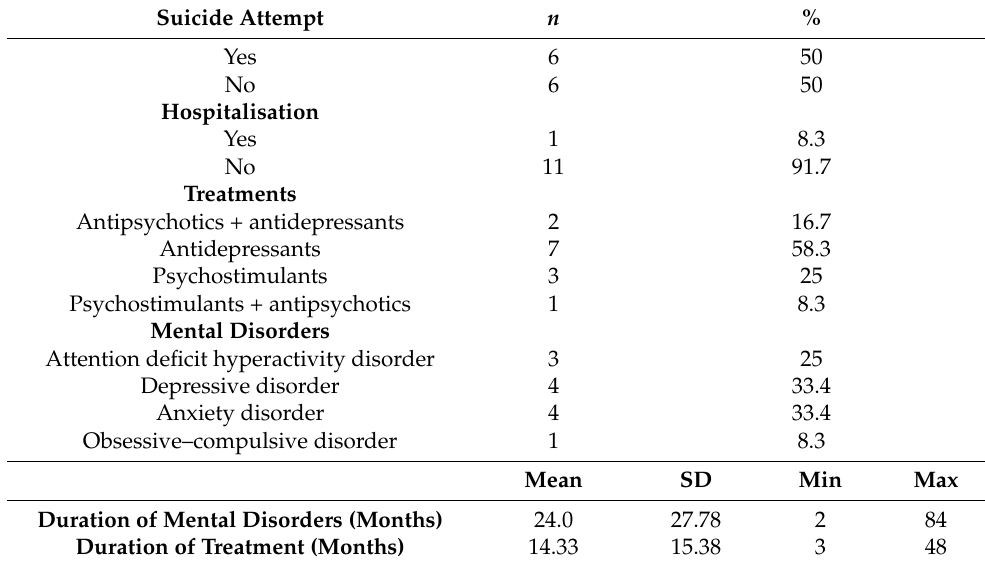
Table 2. Mental health history of the adolescents.